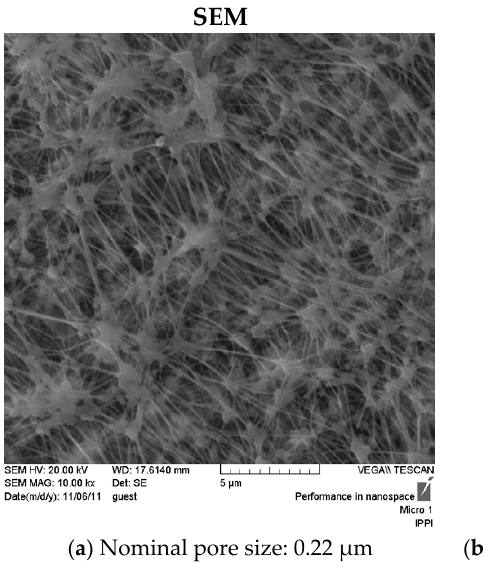
Figure 2. The scanning electron microscopy (SEM) (with 5-µm scale-bar) and atomic force microscopy (AFM) (with 15 µm × 15 µm scanning size) images of the PTFE membrane (with 0.22-µm pore size) used in this work.